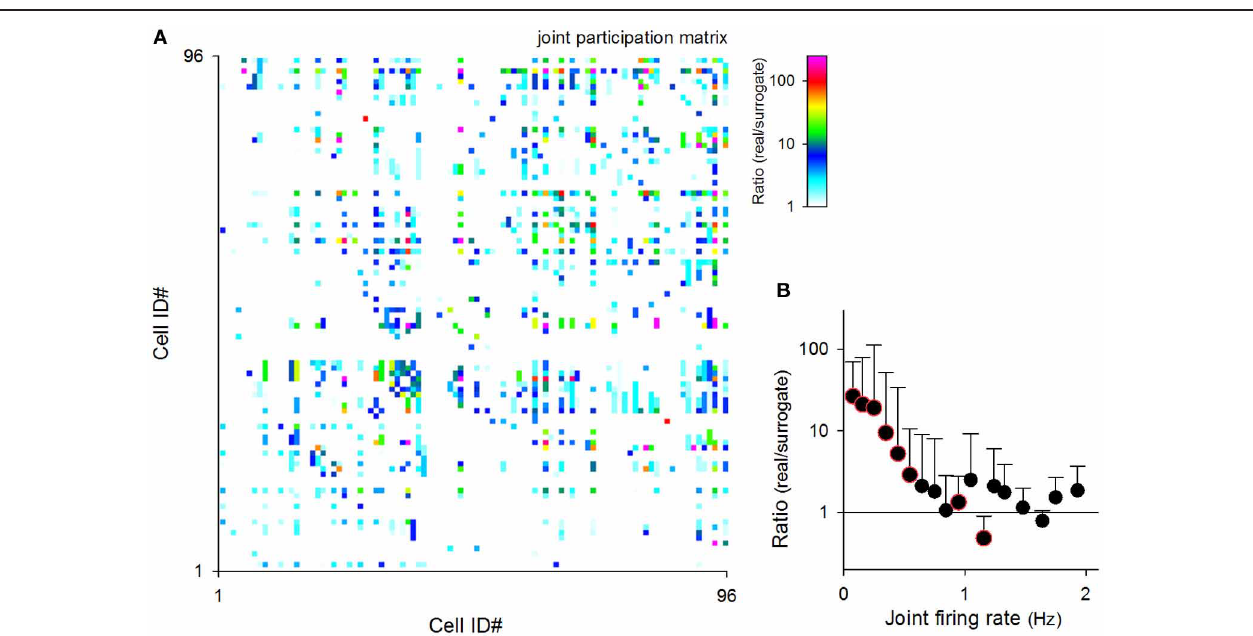
FIGURE 11 | Relationship between the joint firing rates of neuron pairs andtheirMSSjointparticipations.(A) Apseudo-colored matrixrepresenting the numbers of joint participations by two given cells. Data are shown as the ratio of the real rastergrams to their randomized controls. (B) The ratios of the